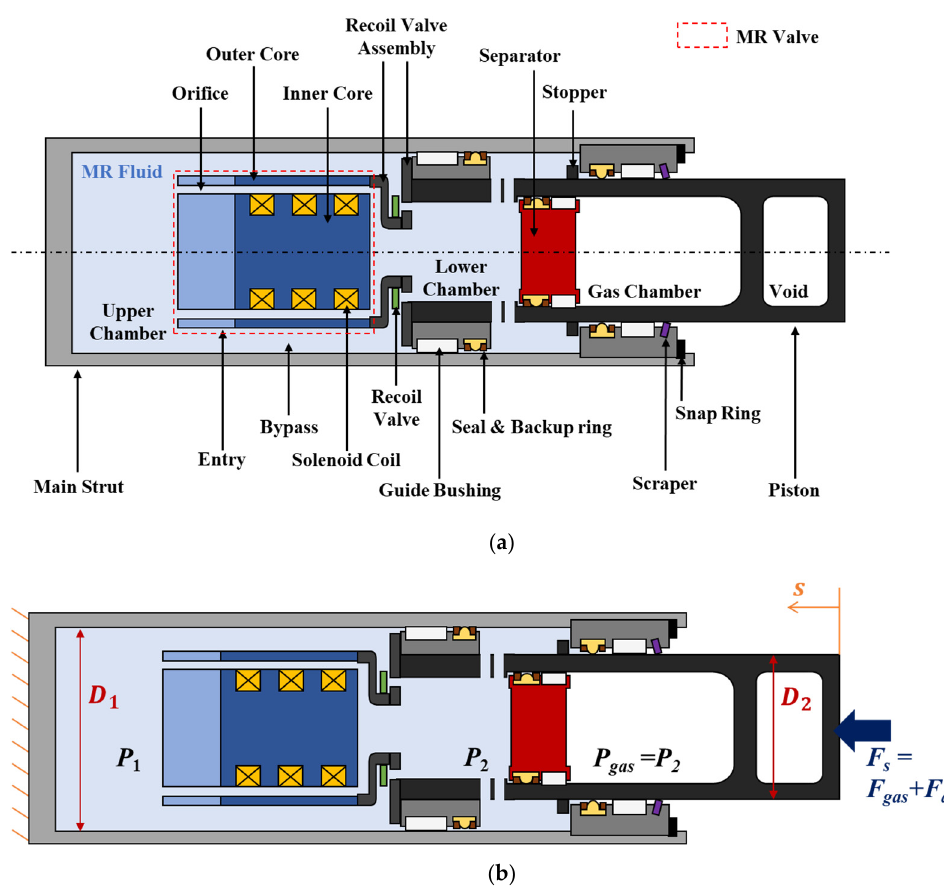
Figure 1. Configuration of aircraft landing gear and MR shock absorber.